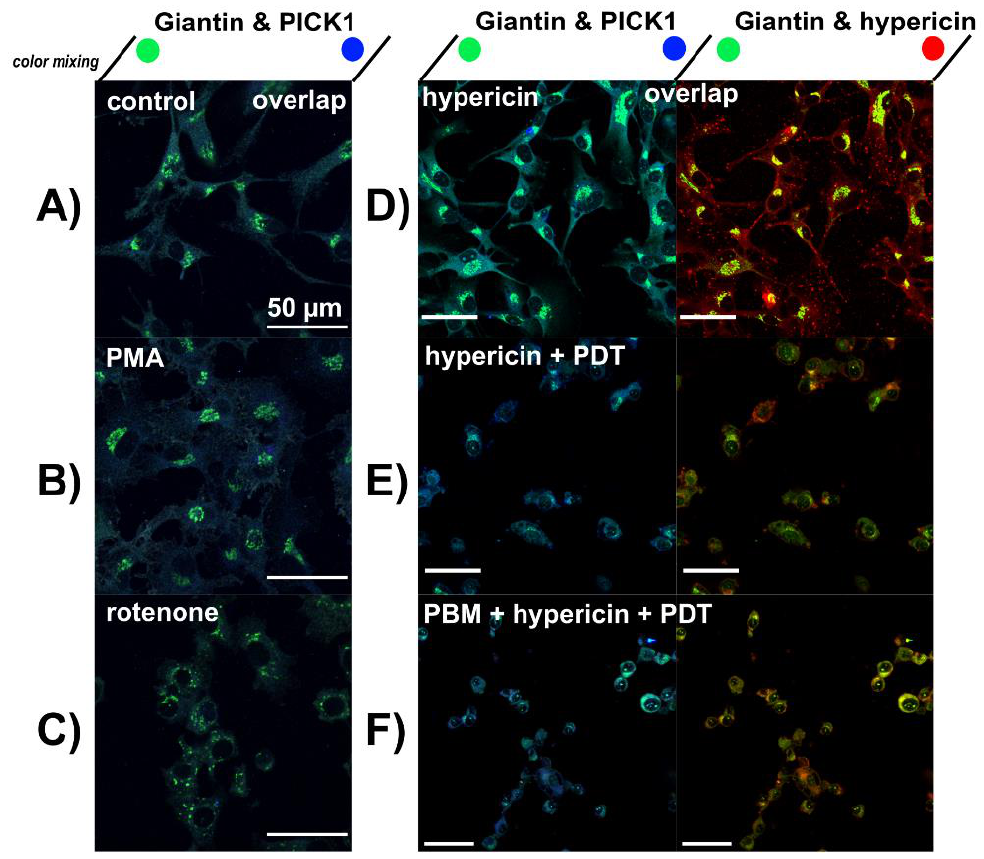
Figure 6. Confocal fluorescence images of Giantin (green), PICK1 (blue) and hypericin (red) in ( A ) U87 MG cells without treatment, ( B ) treated with 1 µM PMA and ( C ) 10 µM rotenone for 5 h. ( D ) cells treated with 500 nM hypericin for 3 h, ( E ) hypericin-PDT and ( F ) PBM-hypericin-PDT detected 5 h after PDT. Scale bar — 50 µm.